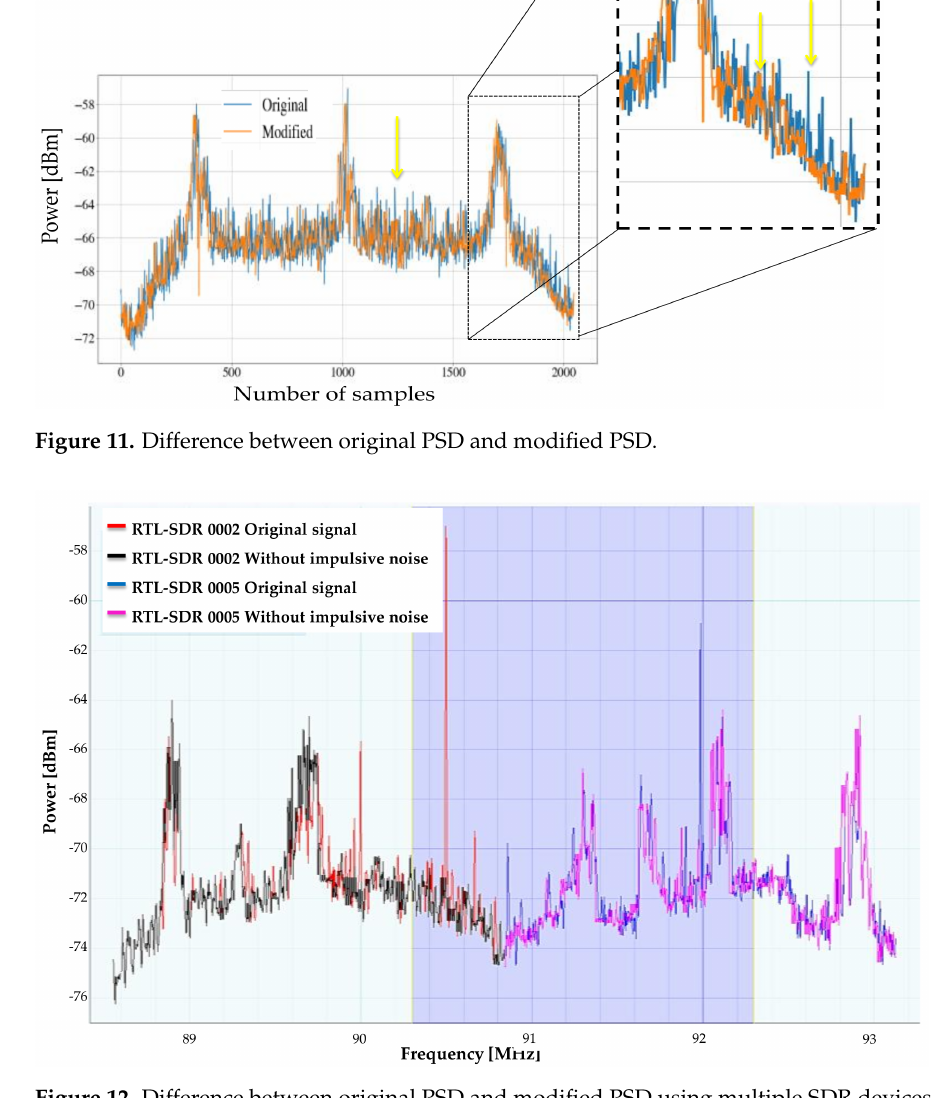
Figure 12. Difference between original PSD and modified PSD using multiple SDR